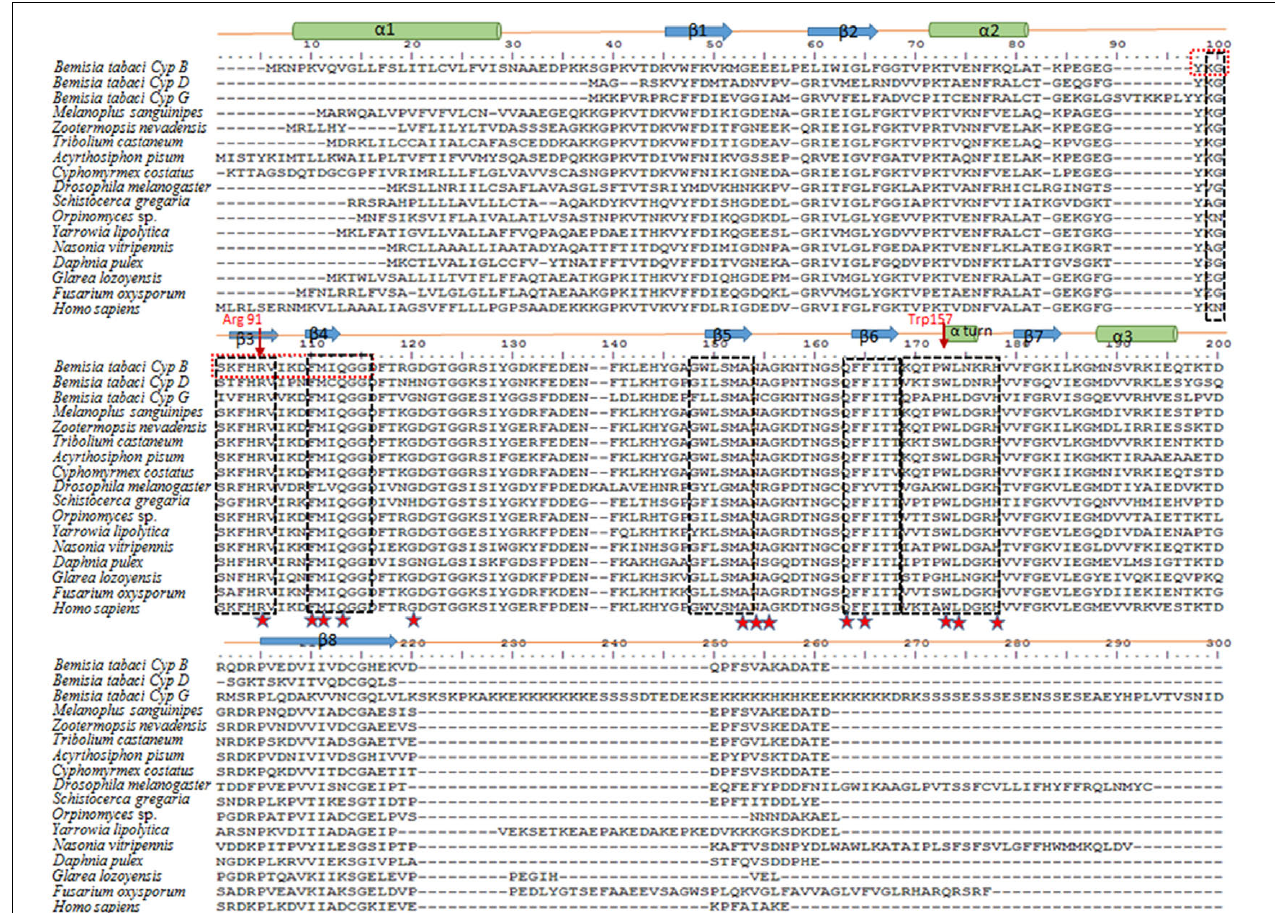
FIGURE 1 | Multiple alignments of Bemisia tabaci CypB, CypD, and CypG amino acid sequences with other arthropod, fungal, and human CypB amino acids sequences. ‘ β 1–8’ indicates β -strand; ‘ α 1–3’ indicates α -helix; The CypB inhibitor cyclosporin A (CsA)-binding domains (four β -strands) are indicated on the top of sequences and are boxed. The 13 well-conserved residues that constitute the CsA-binding site are marked with star symbol. The signature of peptidyl-prolyl- cis - trans isomerase (YKGSKFHRVIKDFMIQGG) is represented in red colour box. Accession numbers are: Melanoplus sanguinipes ALX00032 , Zootermopsis nevadensis KDR13508 , Tribolium castaneum XP 971028 , Acyrthosiphon pisum NP 001156707 , Cyphomyrmex costatus KYN04146 , Drosophila melanogaster NP 476656 , Schistocerca gregaria AEV89763 , Orpinomyces sp. Q01490 , Yarrowia lipolytica XP 504296 , Nasonia vitripennis XP 001602615 , Daphnia pulex EFX68543 , Glarea lozoyensis EHK99826 , Fusarium oxysporum EXL62949 , Homo sapiens P23284.